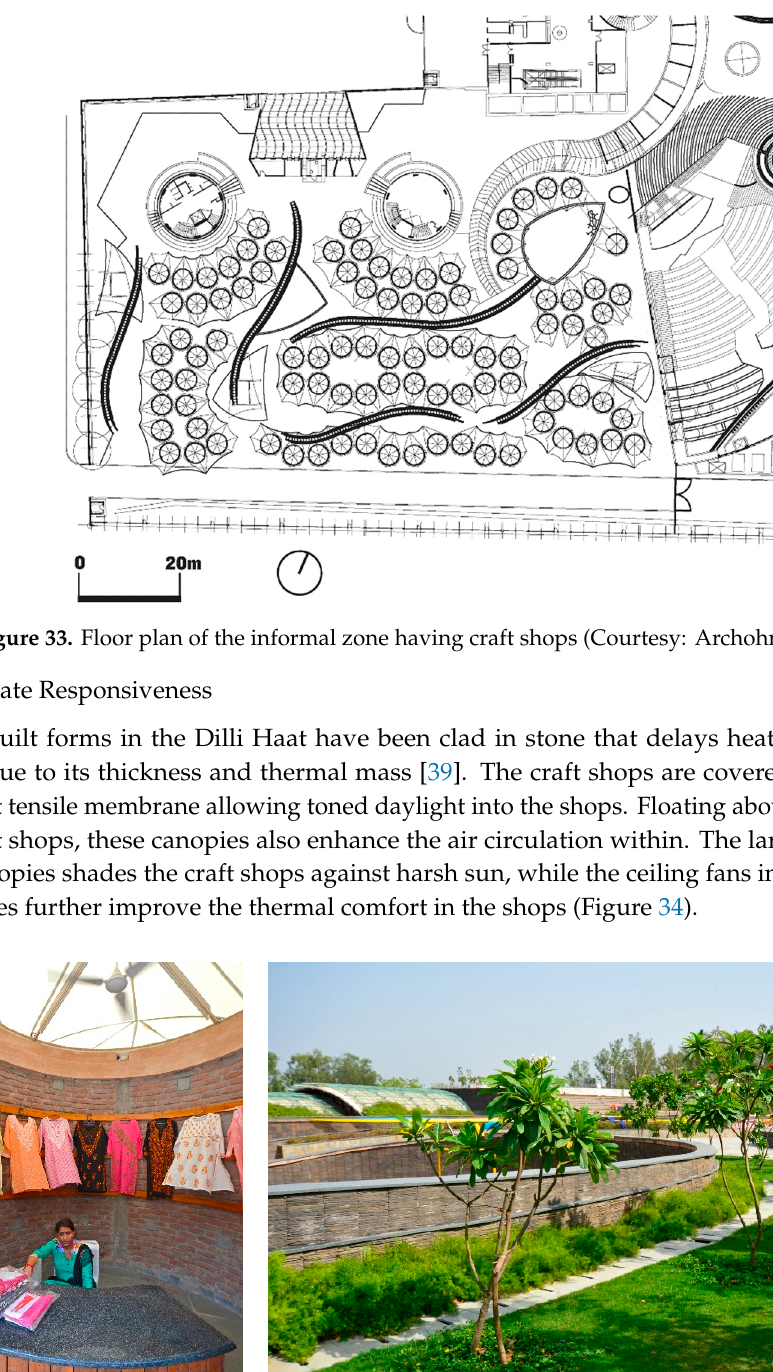
( b ) Figure 35. Cladding materials used in Dilli Haat Janakpuri: ( a ) Delhi Quartzite Stone and ( b ) bamboo (Photo: Author). 3.5.5. Local Materials and Construction The idea of Dilli Haat Janakpuri was based on two other Dilli Haats developed by the same client in other parts of Delhi, one in 1994 and another in 2007. The material palette in both the earlier Dilli Haats is dominated by exposed brickwork. In order to create a unique identity for Dilli Haat Janakpuri, Sourabh Gupta had to opt for other locally-available materials besides brick. Therefore, different varieties of stone such as Delhi quartzite, Kota stone, red Agra sandstone and slate are used for cladding and paving (Figure 35).